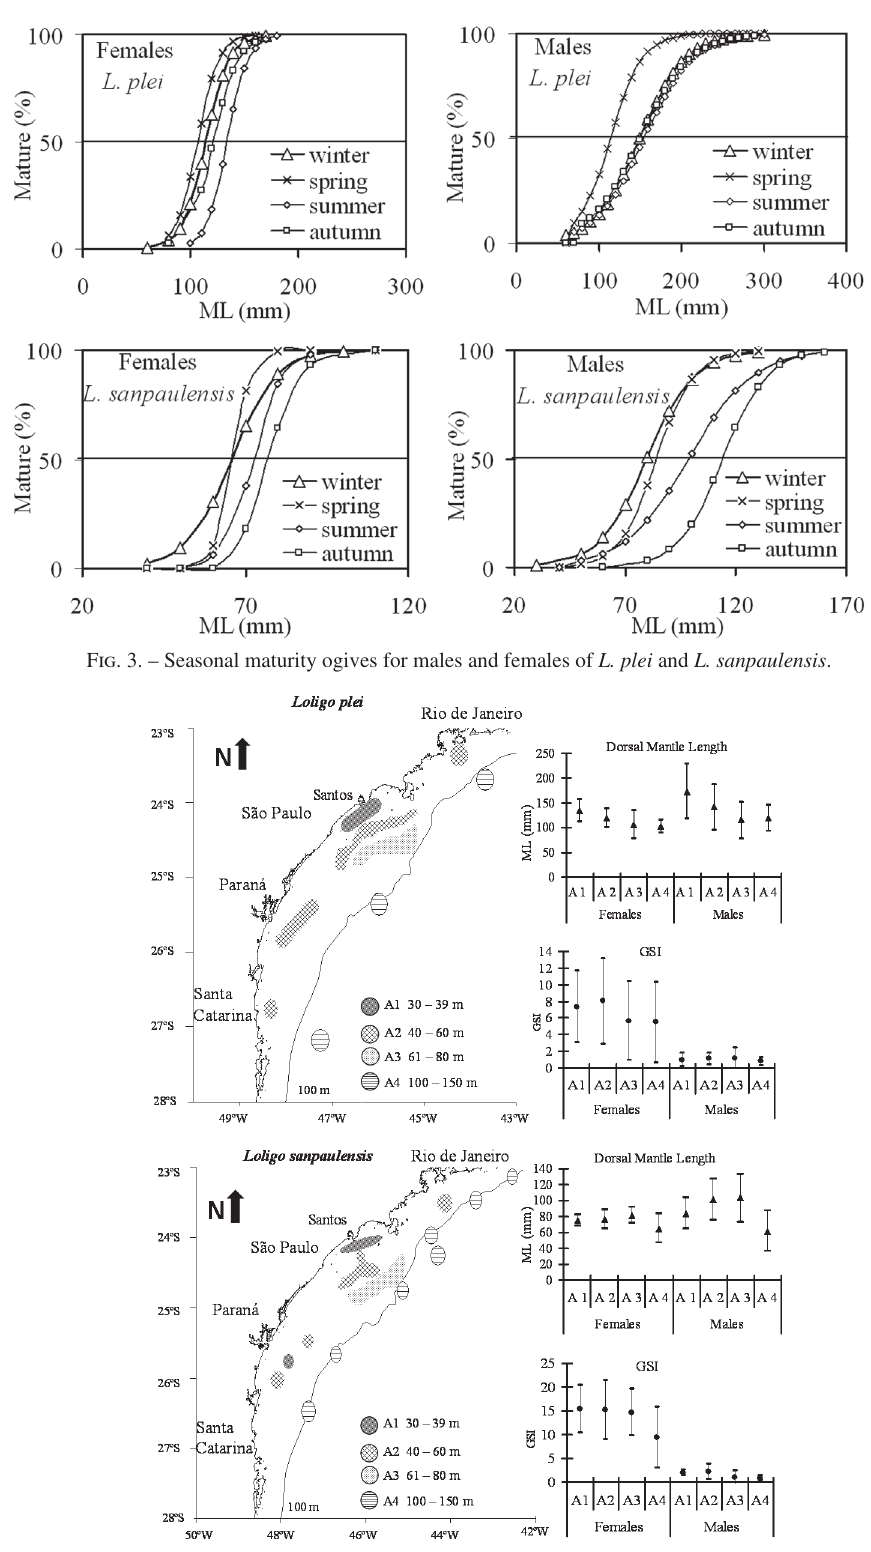
Fig. 4 . – Cross-hatched areas represent the catch location of L. plei and L. sanpaulensis by depth strata (A1: 30-39 m, A2: 40-60 m, A3: 61- 80 m and A4: 100-150 m). On the right, mean and standard deviation of mantle length (mm) and gonado-somatic index (GSI) are shown for each depth stratum and